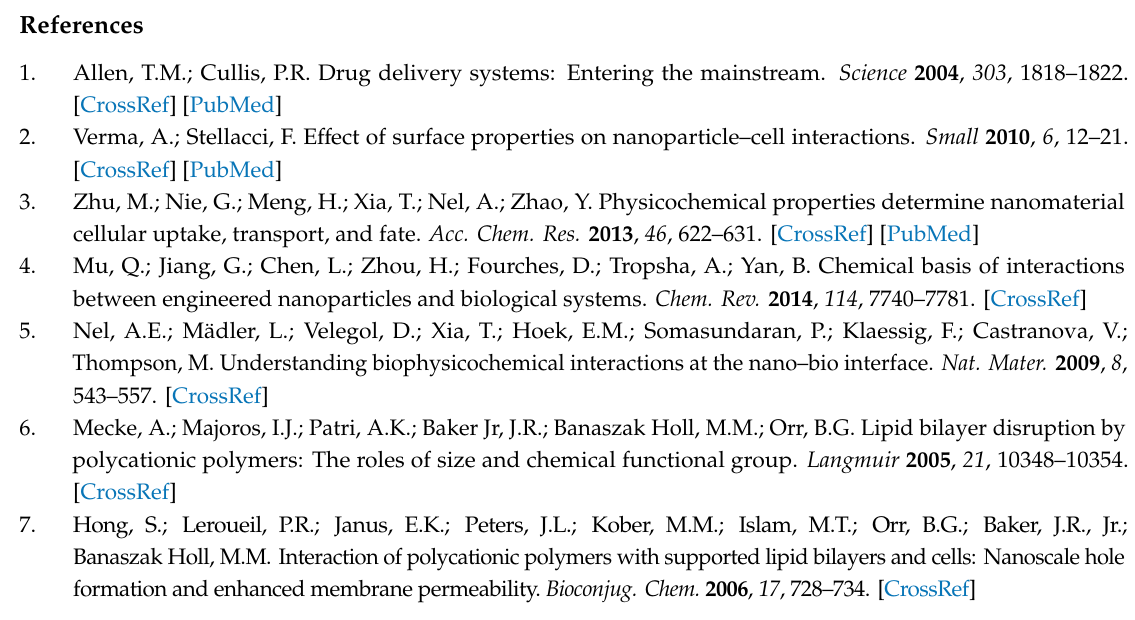
Table S1: Collapse surface pressures, limiting molecular areas, and maximum elastic moduli determined from π -A